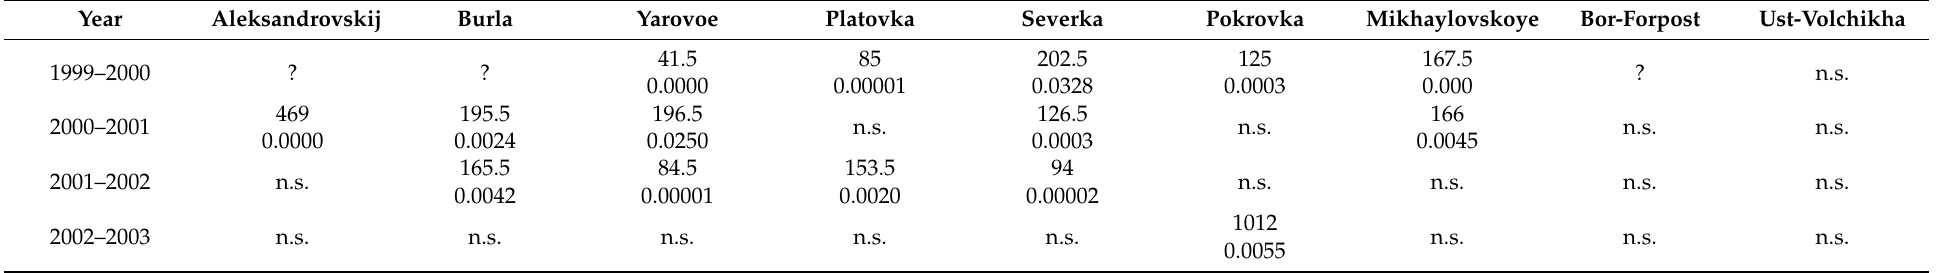
+—One or several specimens were found beyond counts; ?—no data for this year. Table 2. Mann–Whitney U test (U/ p < 0.05) for the status of Italian locust populations for every consecutive pair of years in the Kulunda